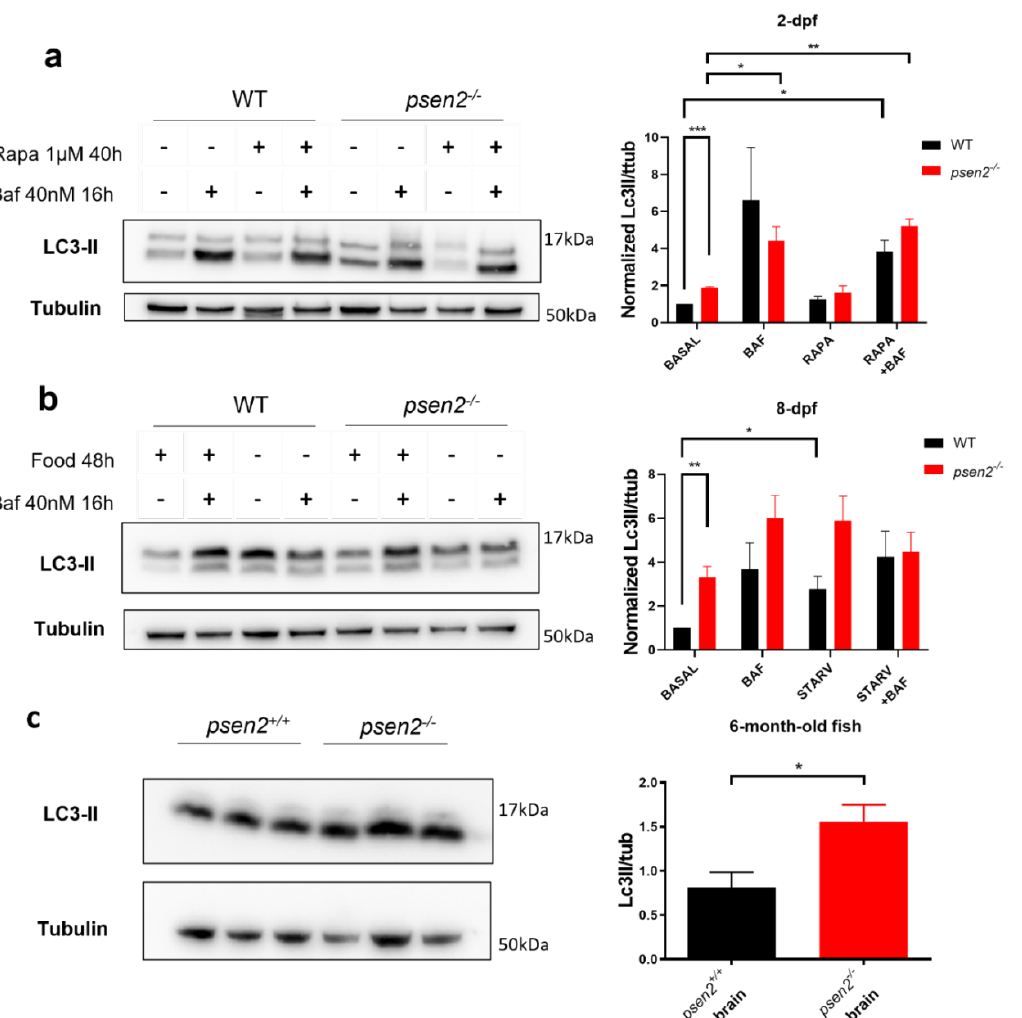
Figure 6. Effect of Psen2 absence on autophagy. ( a , b ) Representative blots and relative quantifications of LC3-II levels (normalized to tubulin levels) in WT and psen2 − / − embryos or larvae at ( a ) 2- and ( b ) 8-dpf, respectively, in basal conditions or upon the induction of autophagy (by rapamycin, RAPA), in the presence or not of the lysosomal inhibitor bafilomycin (BAF). ( a ) Pools of 15 WT and psen2 − / − embryos were treated with either vehicle (DMSO) or 1 µ M Rapamycin (Rapa) from 8- to 48-hpf (to induce autophagy), with or without the addition of 40 nM Bafilomycin (Baf) at 32-hpf (final 16 h-treatment with the lysosomal inhibitor). Mean ± SEM, n = 3 independent experiments. ( b ) Pools of 10 6-dpf WT and psen2 − / − larvae either fed (3 times per day) or starved for 2 days, treated or not with 40 nM BAF for the last 16 h of the experiment. Mean ± SEM, n = 3 independent experiments. ( c ) Representative blot and relative quantification of LC3-II levels (normalized to tubulin levels) in the brains of psen2 +/+ and psen2 − / − 6-month-old fish. Data were generated from 3 brains for each genotype. Values represent the mean ± SEM. * = p < 0.05; ** = p < 0.01; *** = p < 0.001.